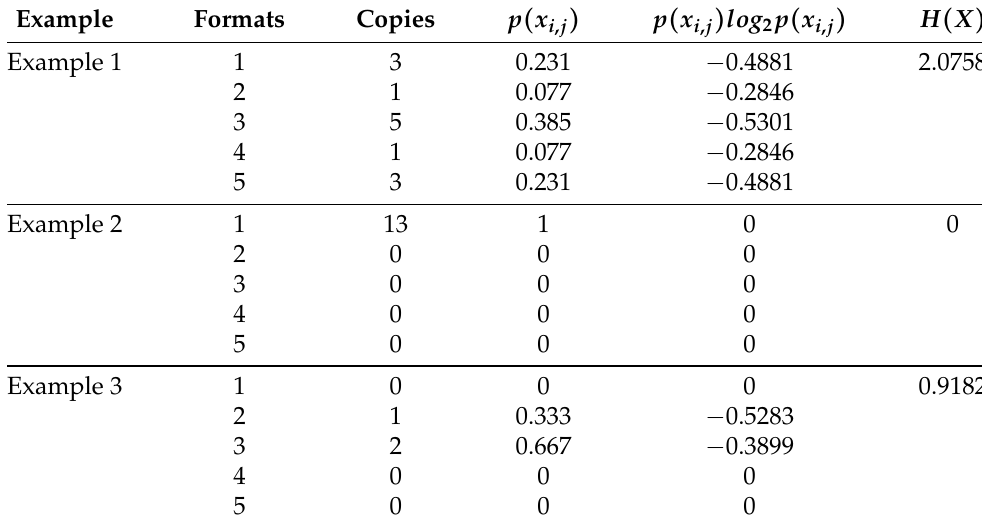
Table 1. Random examples of entropy as a measure of